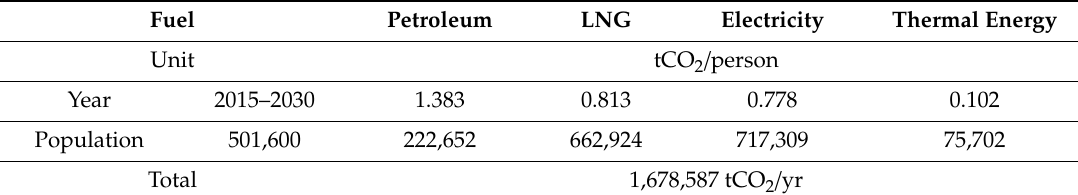
Table 3. The CO 2 Emissions Prediction of 2015–2030 (CO 2 Emissions Per Capita) a . Fuel Petroleum LNG